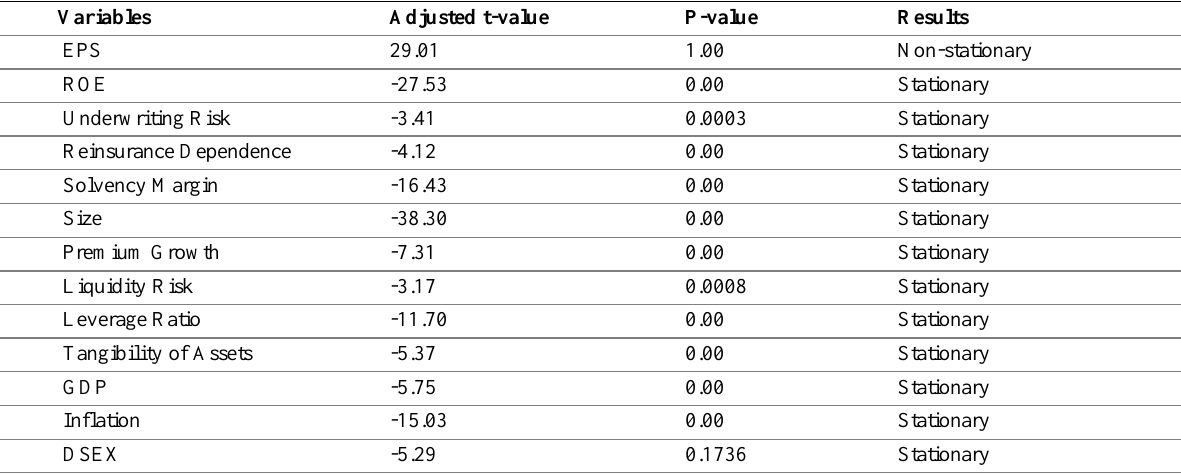
Table 13: Summary of the output of LLC Unit-root